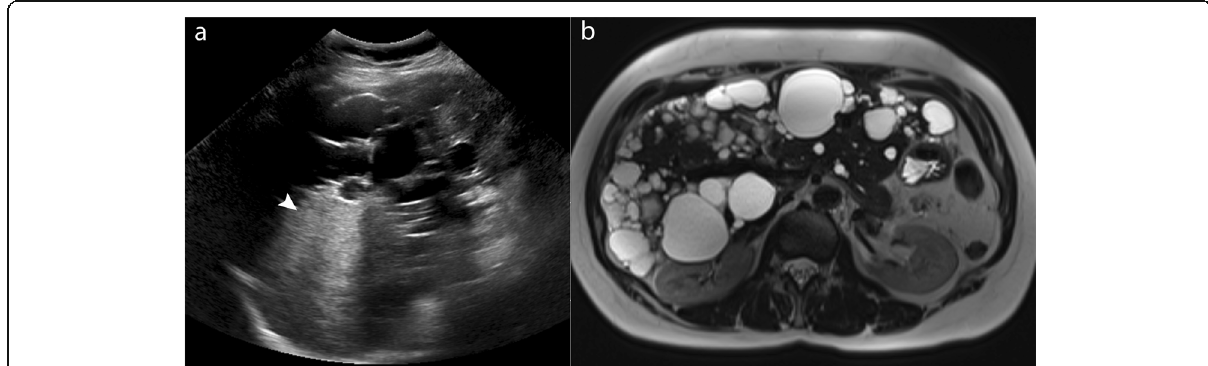
Fig. 3 A 58-year-old female patient with chronic hepatitis B and polycystic liver. a Heterogeneous posterior acoustic enhancement (arrowhead) limits lesion detection on ultrasound. b The cysts do not affect liver parenchymal visibility with